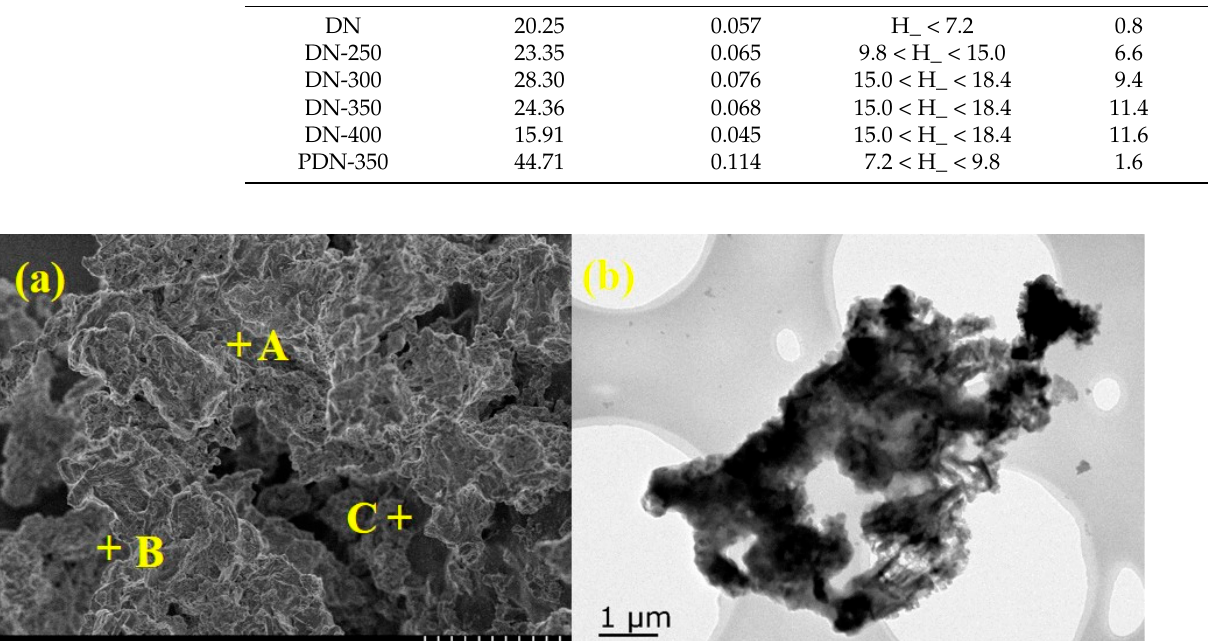
Figure 3. The N 2 adsorption–desorption curve of the samples ( a ) and the TGA measurement of the DN-350 catalyst ( b ). Table 2. EDX analysis of DN-350 catalyst. Sample